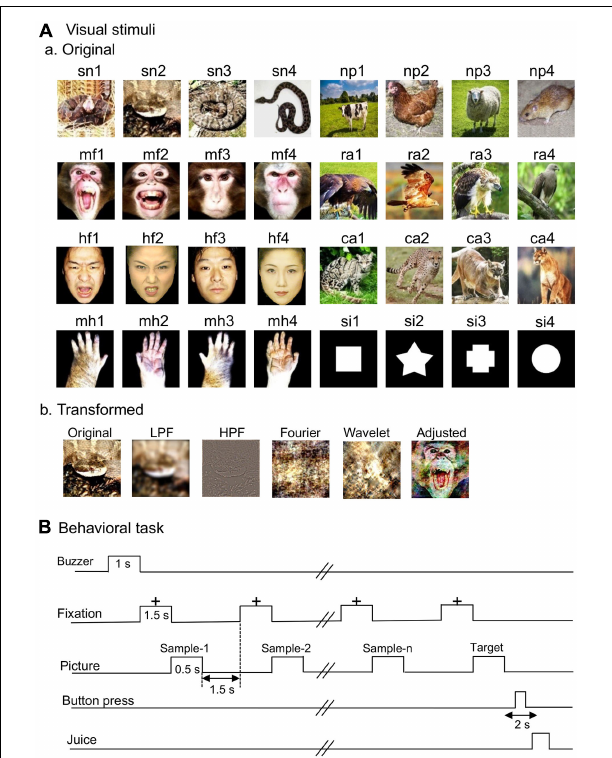
FIGURE 1 | Visual stimuli (A) and delayed non-matching-to-sample (DNMS) task (B) . (Aa) Non-transformed original stimuli. Thirty-two photos of eight categories of the visual stimuli including snakes, monkey faces (emotional and neutral faces), human faces (emotional and neutral faces), monkey hands, non-predators, raptors, carnivores, and simple figures. (Ab) Transformed stimuli. LPF, low-pass filtered images; HPF, high-pass filtered images; Fourier, Fourier-scrambled images; Wavelet, wavelet-scrambled images; Adjusted, adjusted visual images. (B) Schematic illustration of the DNMS task